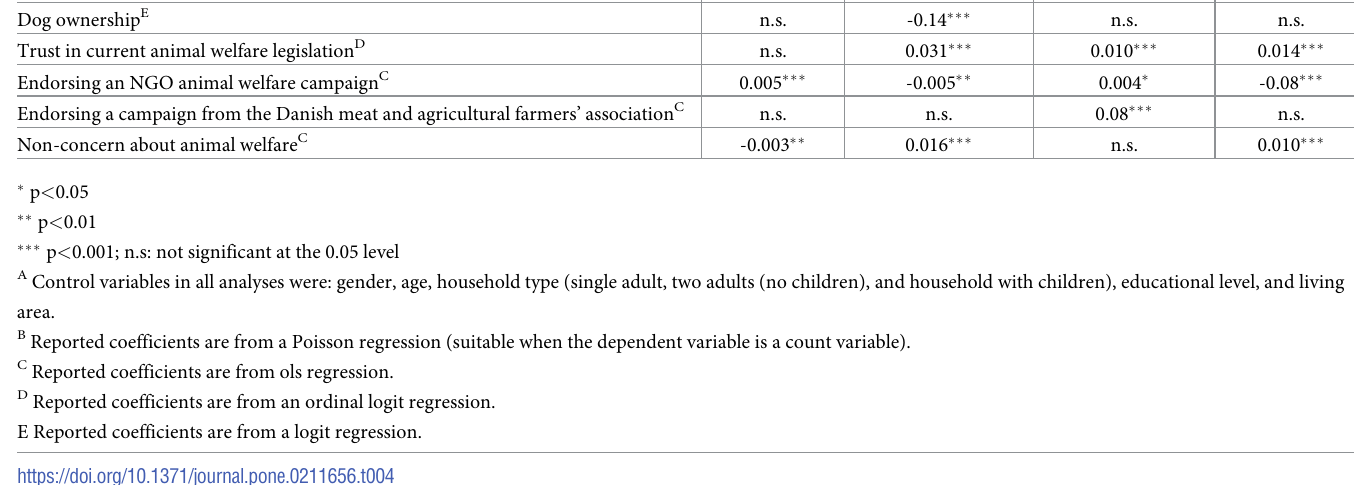
tor, although it does exhibit a weak association with the animal protection orientation.